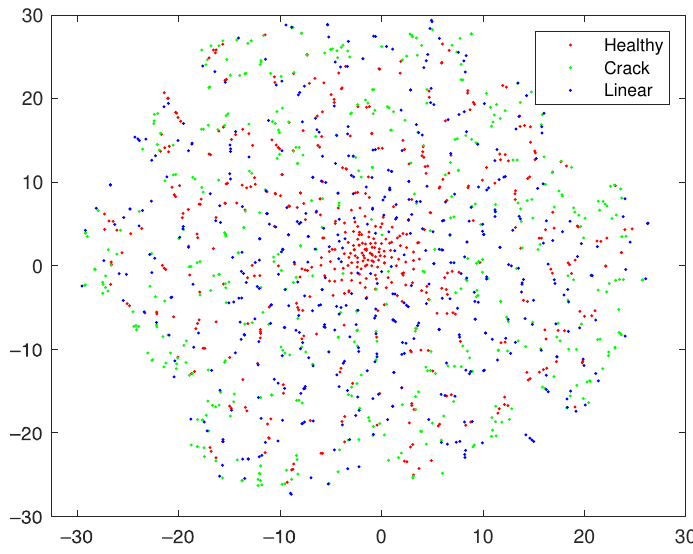
Figure 16. t-DSNE visualization of the samples composed by the spot images. It is possible to see that the deterministic feature extraction helps the classification, but it is still not accurate enough.